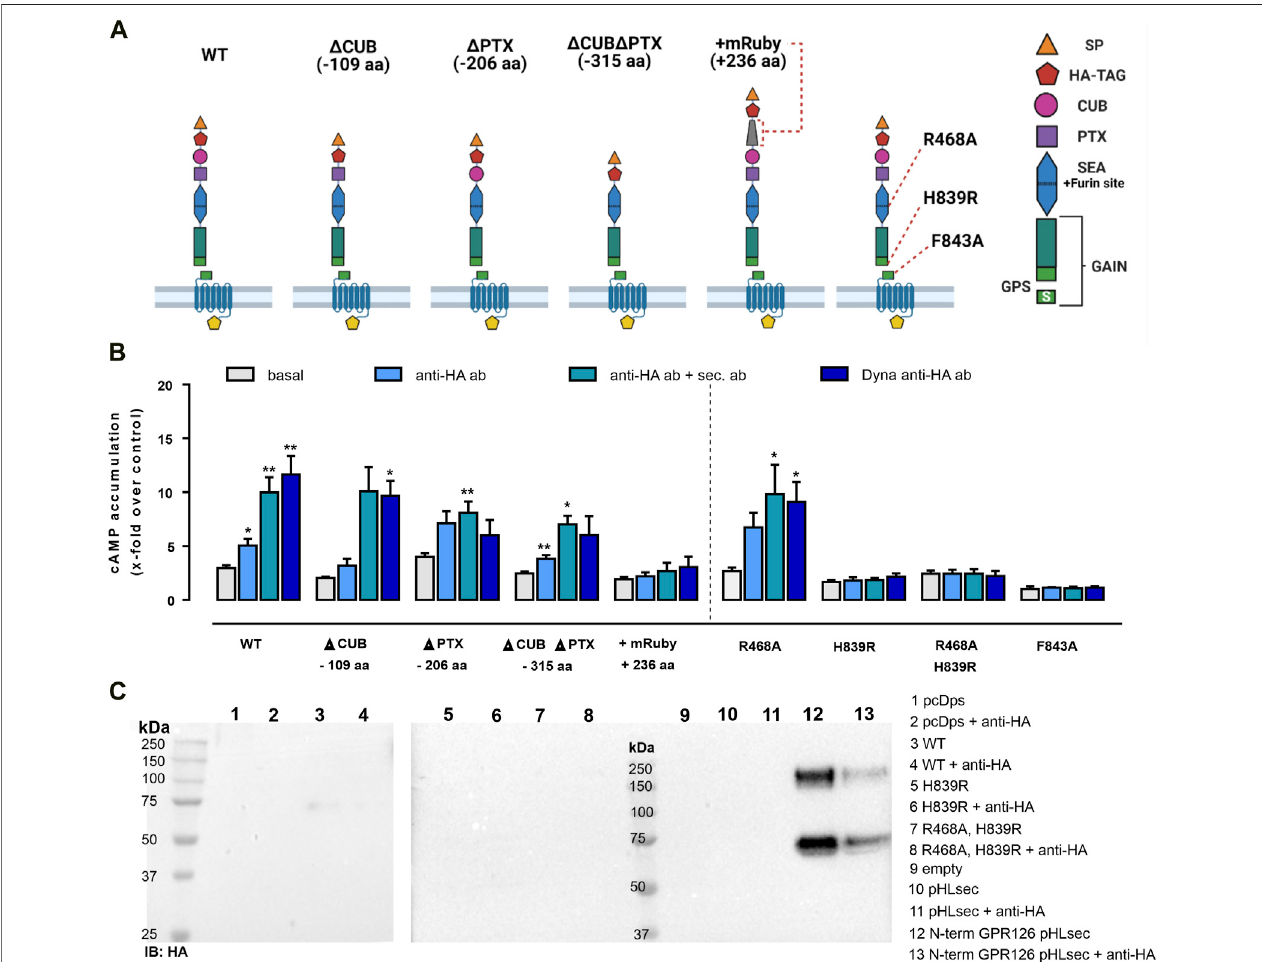
FIGURE 2 | Antibody-mediated activation of GPR126 depends on autoproteolytic cleavage and is obliterated in a construct with an elongated N terminus. (A) Domain architecture of the human GPR126 WT and respective mutants is depicted. The positions of the furin-de fi cient receptor mutant R468A, the GPS cleavage mutant H839R, and the tethered agonist mutant F843A within the N terminus are displayed. Images were created with BioRender.com. (B) Receptor variants were transfected into COS-7 cells and analyzed with the same antibody-based approach as used in Figure 1 and tested in cAMP assays. An empty vector (pcDps) served as a negative control (cAMP level: 4.3 ± 0.7 nM/well). Data are given as mean ± SEM of three – eight different experiments each performed in triplicates. Statistics wereperformed byapplyingone-wayANOVA followed byDunnett ’ spost hocanalysis; * p < 0.05; ** p < 0.01; *** p < 0.001. Allshown statistical signi fi cance compare the condition to the basal cAMP accumulation of the same construct. Corresponding raw data can be found in the repository. (C) COS-7 cells were transfected with the indicated constructs and treated with 1 µg/ml mouse anti – HA ab for 1 h, 48 h after transfection. Then, supernatants were harvested and analyzed by Western blot. Membranes were incubated with rabbit anti-HA ab and secondary HRP-conjugated anti-rabbit ab. A corresponding Western blot of cell lysates can be found in Supplementary Figure S2C . The secreted N-terminal fragment of GPR126 was only detected when the secretion vector pHLsec containing just the N-terminal fragment of GPR126 as a positive control was